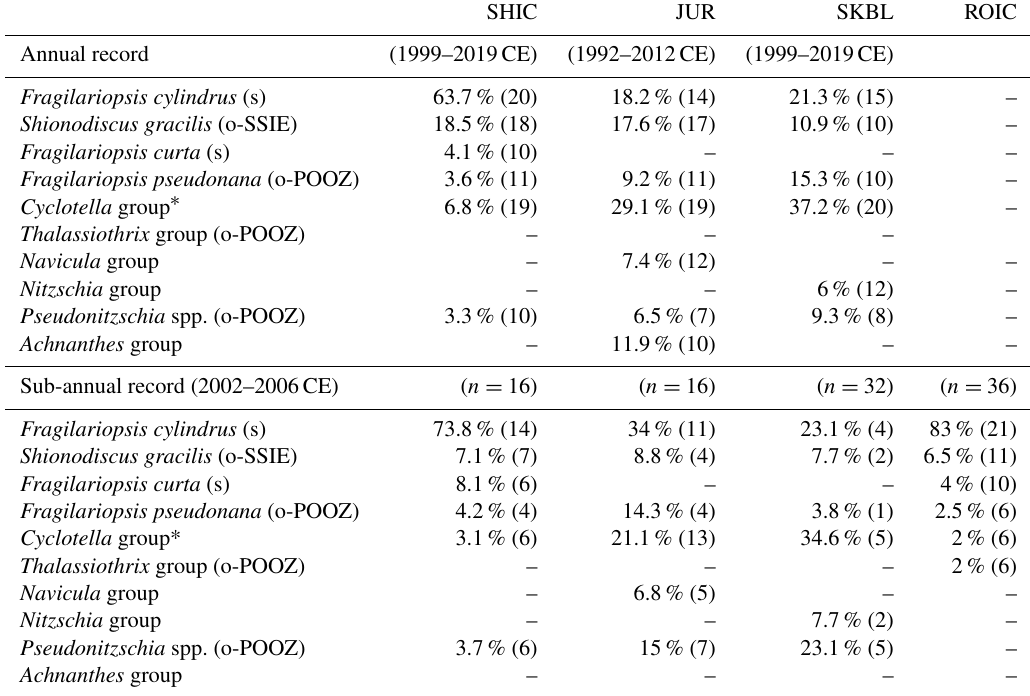
Table 3. Relative abundance (%) and frequency (number of samples) of main diatom taxa in annual and sub-annual diatom records for each ice core. ( ∗ ) Specimens of Cyclotella sensu lato (including Lindavia, Discostella, Tertiarius , and Pantocsekiella and other morphologically similar types). n represents the total number of samples in each sub-annual record. (s): sea ice diatom. (o-SSIE): open ocean – seasonal sea ice edge diatom. (o-POOZ): open ocean – permanently open ocean zone diatom species/group.